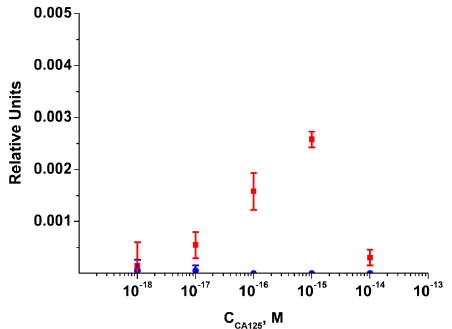
tamers. The number of technical replicates was n = 3. Circles (●) and squares ( ■ ) indicate the average value of the signal level before and after the addition of the CA 125 solution,